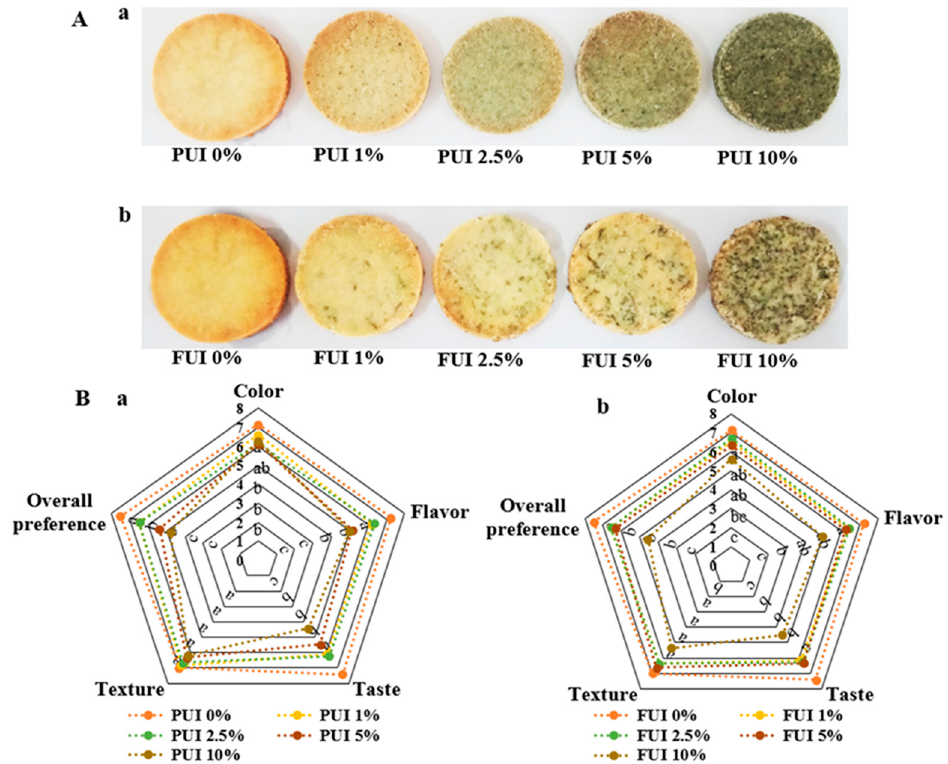
Figure 1. Comparison of different seaweed percentages in biscuit preparation for sensory character- istics. ( A ) Preparation of cookies using powdered UI ( a ) and fragmented UI ( b ). ( B ) Organoleptic analysis of cookies prepared using different concentrations of powdered ( a ) and fragmented ( b ) UI using a radar chart. Data represent the mean ± SE of 3 observations, where groups not sharing a letter are expressed as significantly different ( p < 0.05).